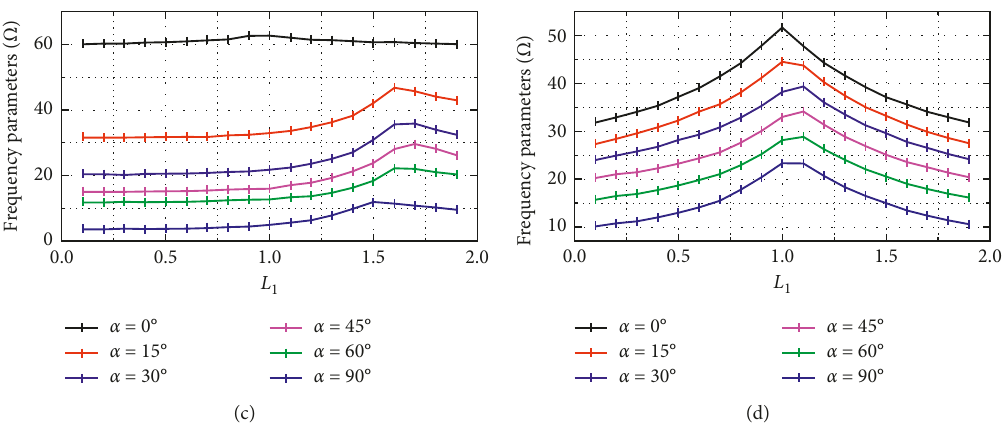
Figure 9: Variation of fundamental frequency parameters for functionally graded open conical shell with a circumferential bulkhead according to axial position of bulkhead ( R